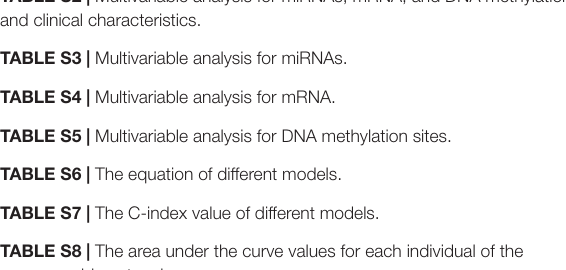
FIGURE S17 | Kaplan–Meier curve of overall survival in the low-genomics-score group stratified by clinical features (e.g., stage). FIGURE S18 | Kaplan-Meier curve of overall survival in the high-genomics-score group stratified by clinical features (e.g., stage). FIGURE S19 | Kaplan–Meier curve of overall survival in stages II and III patients. TABLE S1 | Descriptive statistics of gastric cancer patients. TABLE S2 | Multivariable analysis for miRNAs, mRNA, and DNA methylation sites and clinical characteristics. TABLE S3 | Multivariable analysis for miRNAs. TABLE S4 | Multivariable analysis for mRNA. TABLE S5 | Multivariable analysis for DNA methylation sites. TABLE S6 | The equation of different models. TABLE S7 | The C-index value of different models. TABLE S8 | The area under the curve values for each individual of the genome-wide